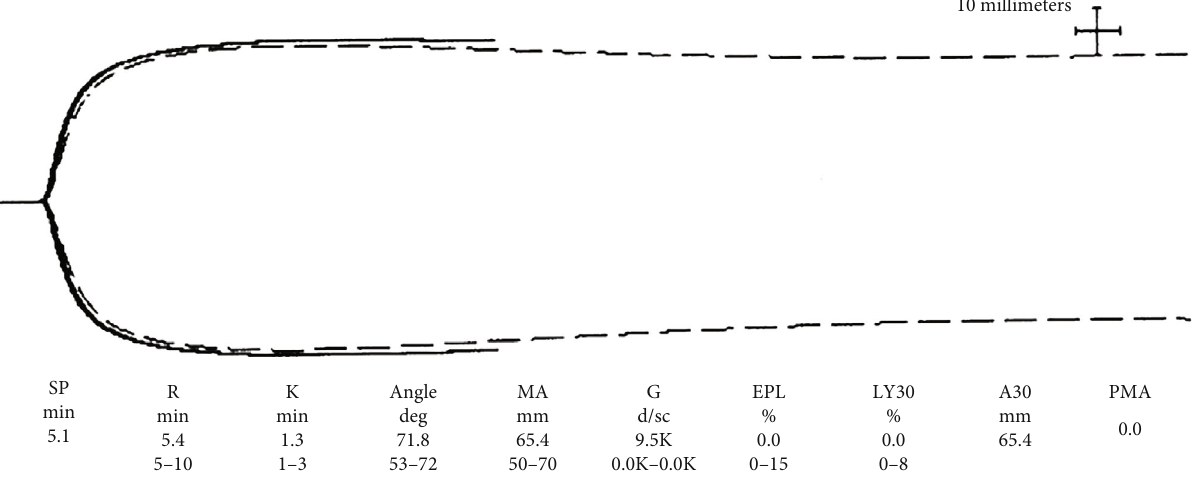
Figure 2: Initial TEG case